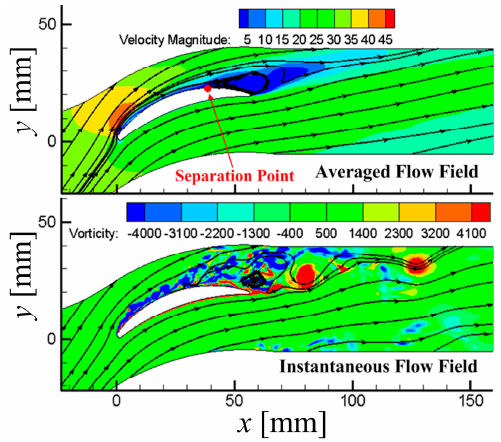
Figure 6. Steady and transient flow structures in the cascade.